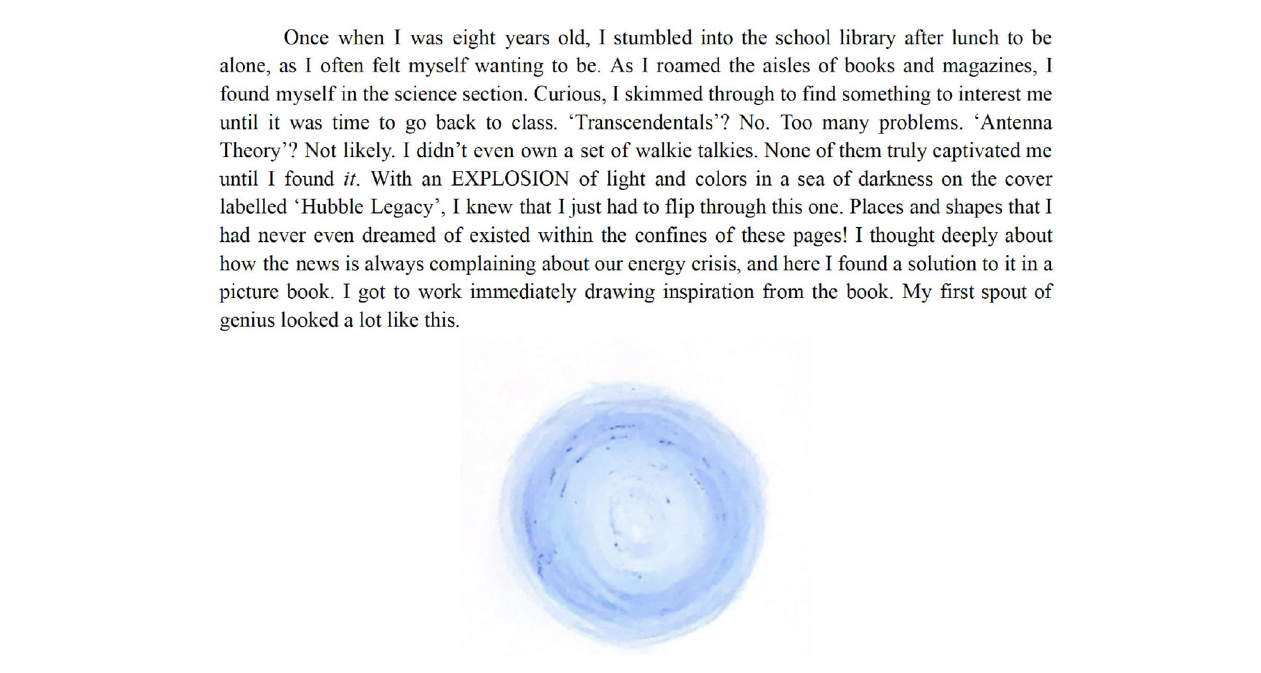
FIGURE20 Section of final project option